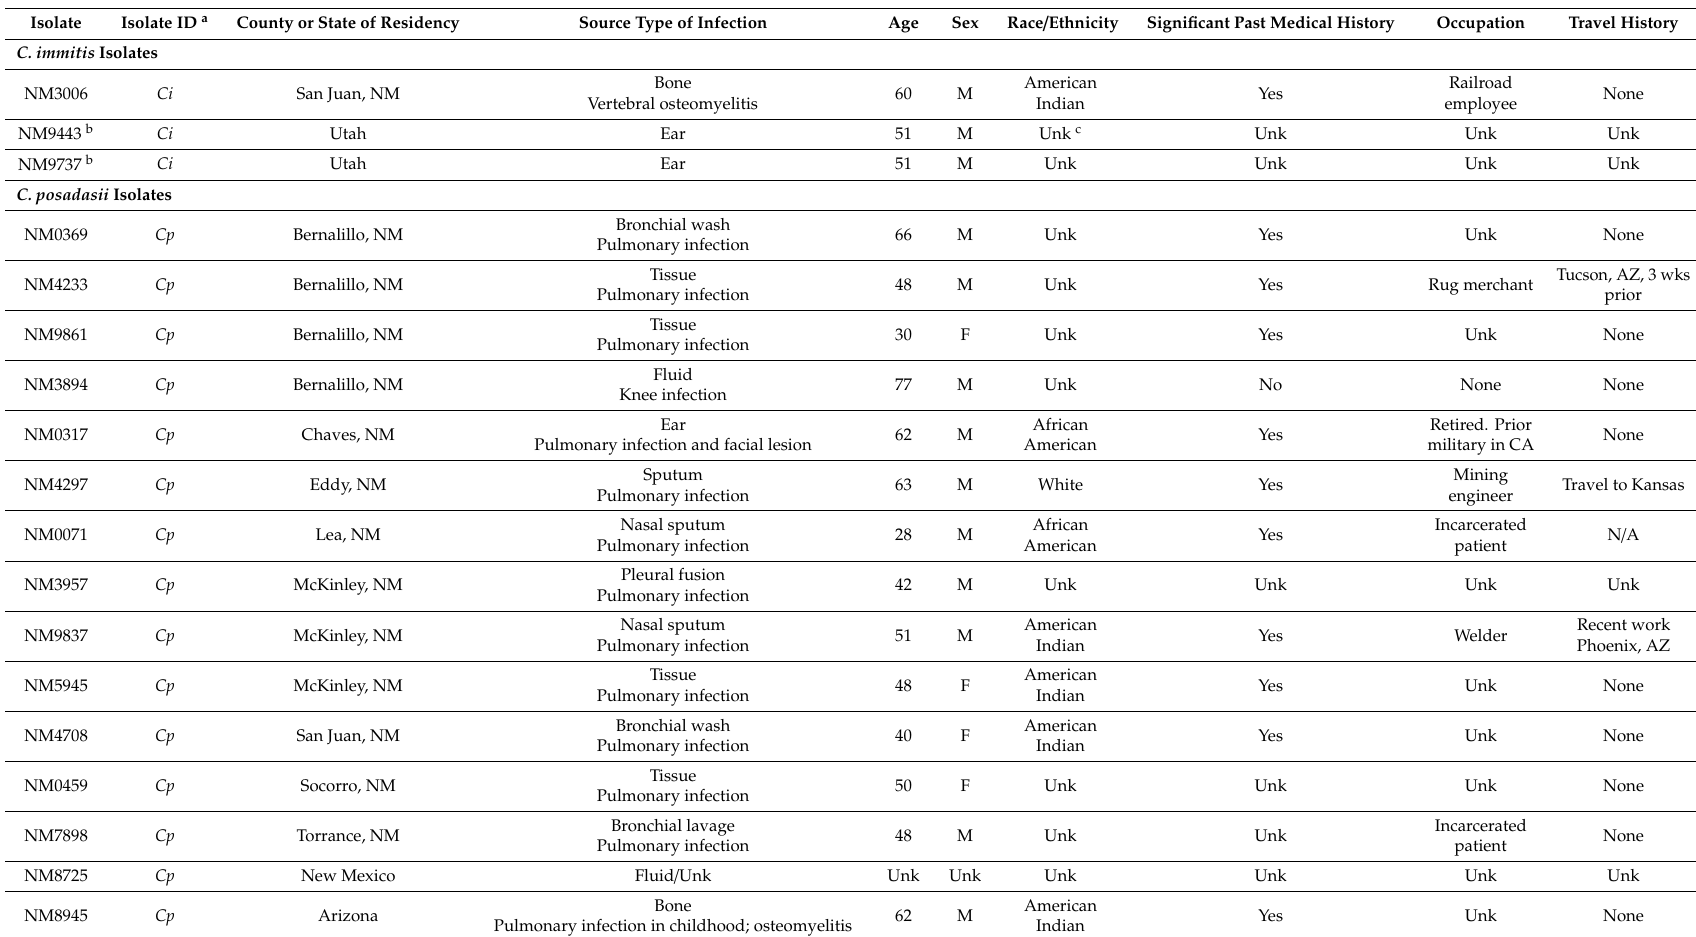
Table 1. Isolate and patient